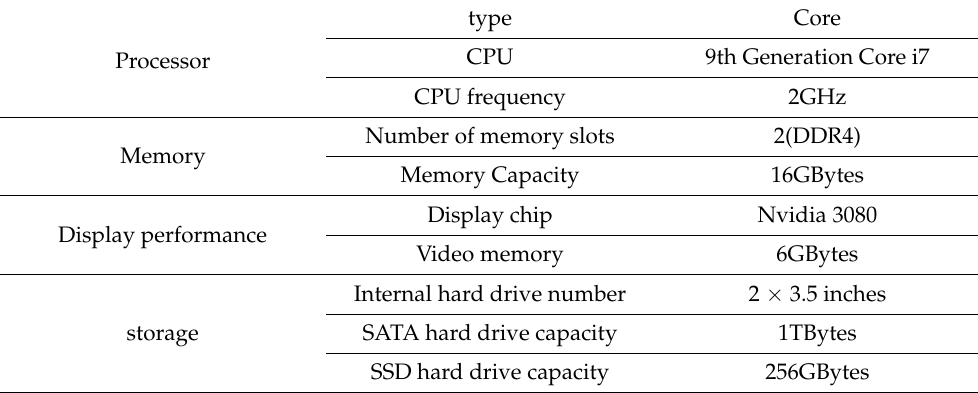
Table 2. Performance test running environment.